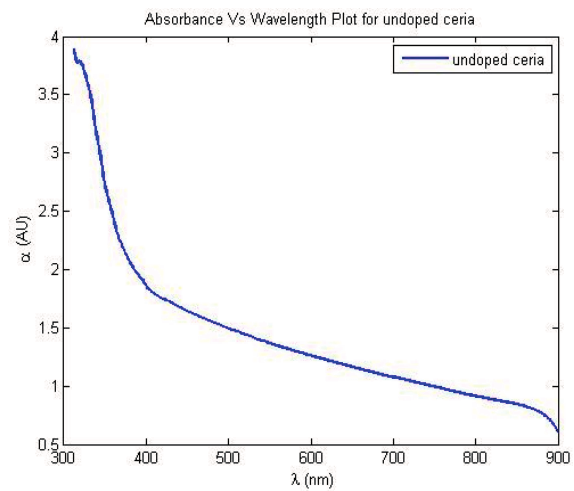
Figure 3. Absorbance dispersion for the synthesized ceria nanoparticles.